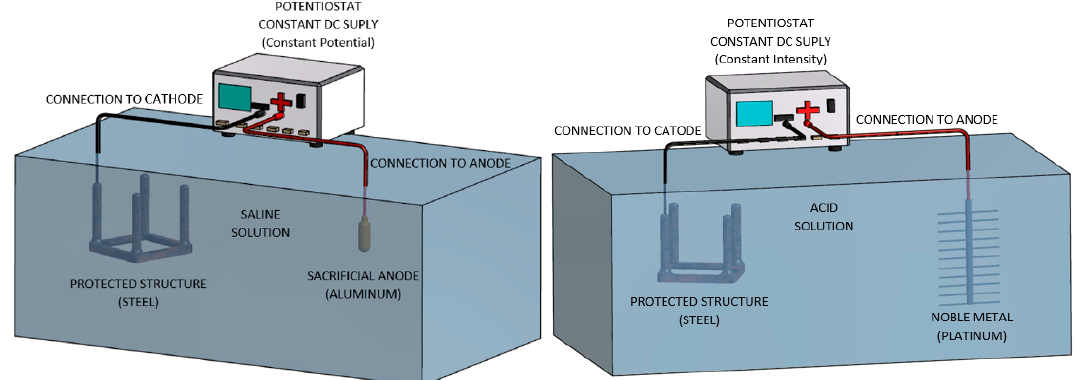
Figure 8. Schema of cathodic protection (left) and cathodic polarization (right) set-ups.